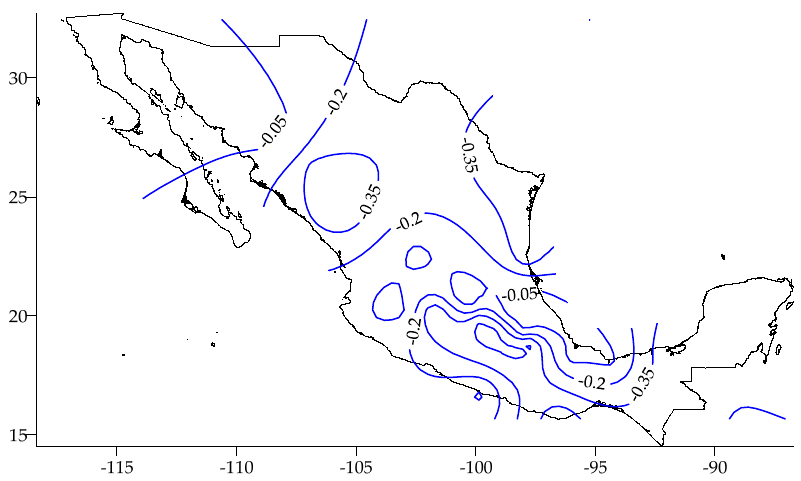
Figure 7. Spatial distribution of alfa parameter of Equation (3).